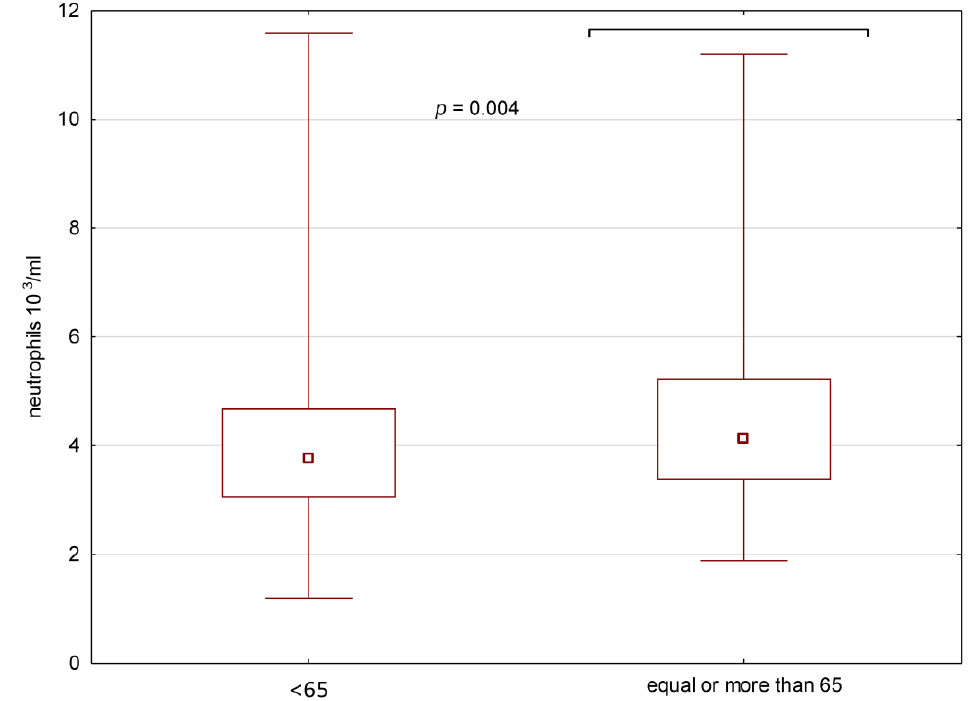
Figure 2. Neutrophils in the peripheral blood in the two groups of patients (≥65 and <65 years of age).